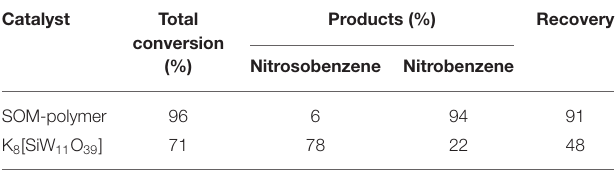
TABLE 2 | Comparison of aniline oxidation a to nitrobenzene by different